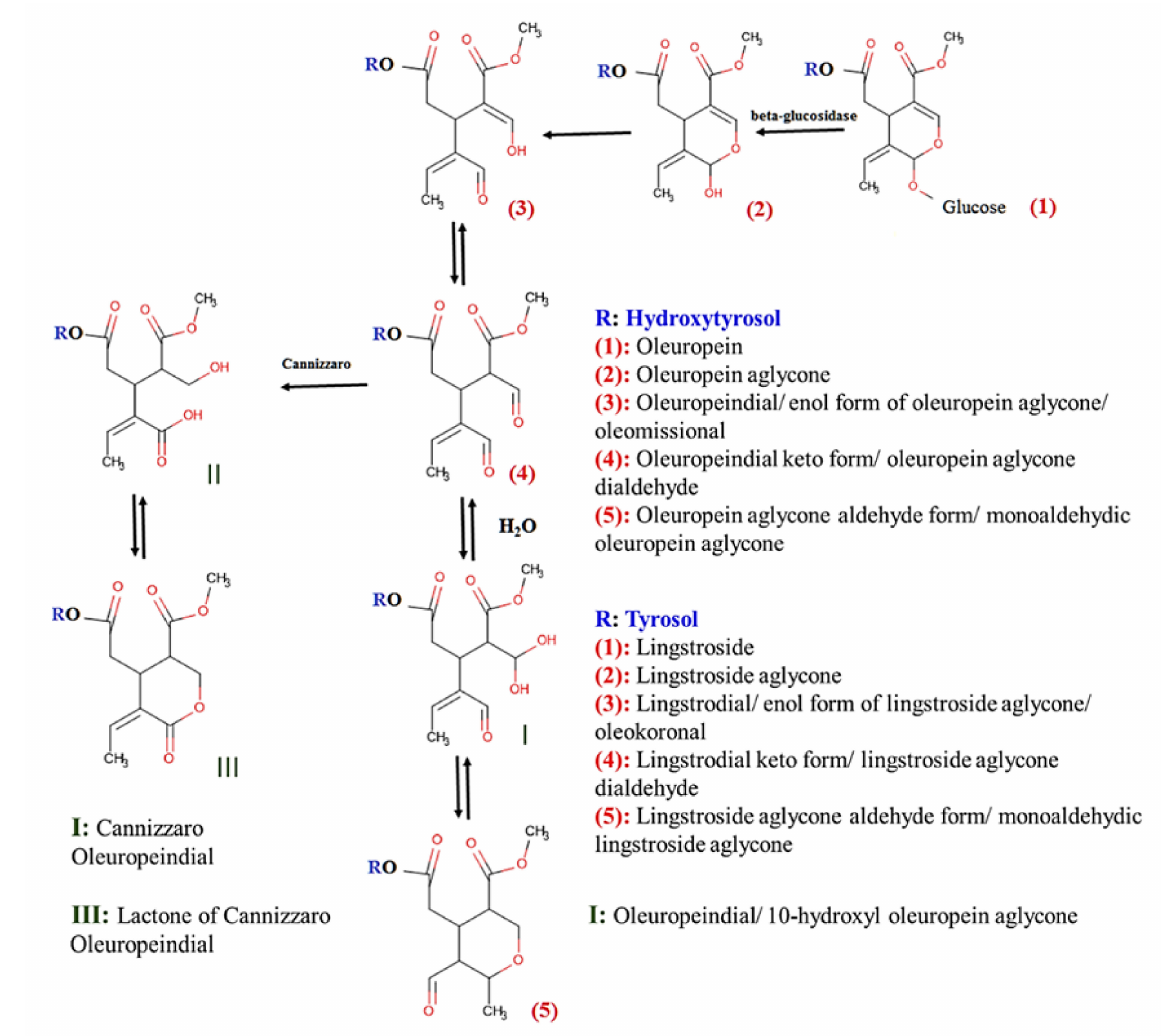
Figure 1. Biotransformation pathway of oleuropein and